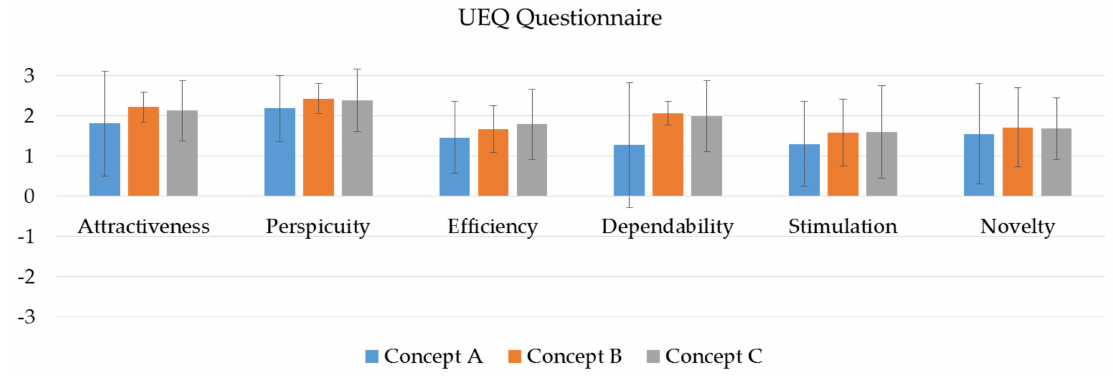
Descriptive analysis of user experience questionnaire (UEQ) depicting all six subscales (attractiveness, perspicuity, efficiency, dependability, stimulation, novelty) for all HMI concept